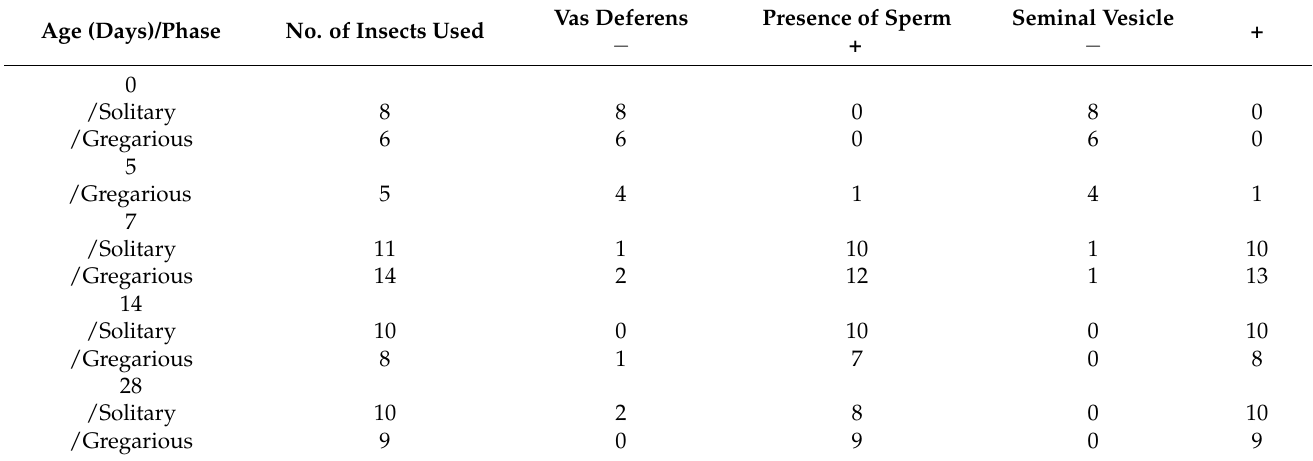
Table 1. Comparison of sperm distribution in the vasa deferentia and seminal vesicle between solitary (S) and gregarious (G) adult males in the desert locust Schistocerca gregaria